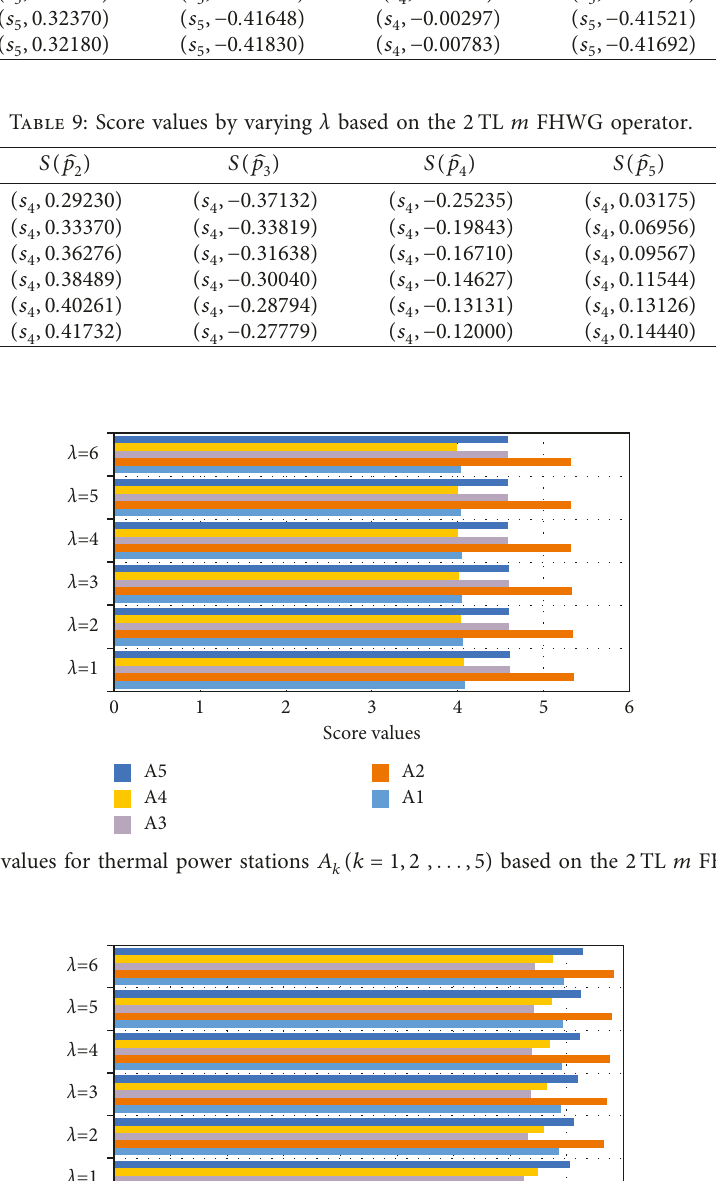
k 1 , 2 , . .. , 5 based on the 2TL m FHWG k ( (cid:26) )